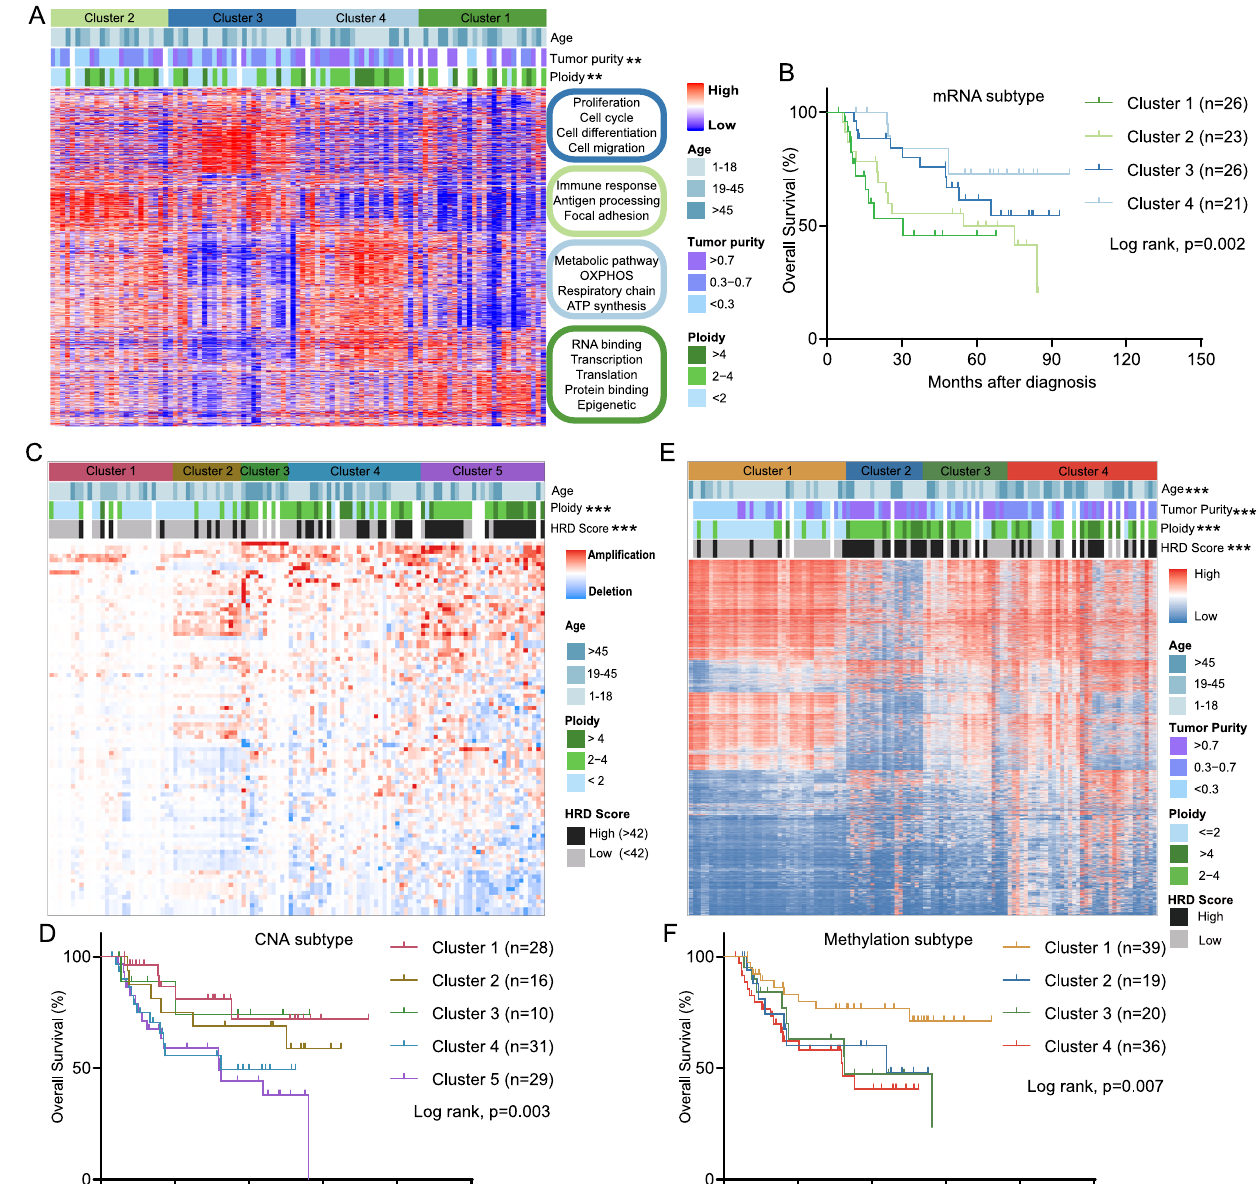
Fig. 3 | Single platform features and the corresponding clinical prognosis. A Transcriptional clustering based on the top 10% most variable genes (1820) across 101 samples. Each column represents one sample and rows indicate genes. B Kaplan – Meier curves for overall survival based on transcriptional clusters (log- rank test). C Copy number clustering based on SCNAs identi fi ed by GISTIC 2.0 in 116 samples. Each column represents one sample, and rows indicate CNA